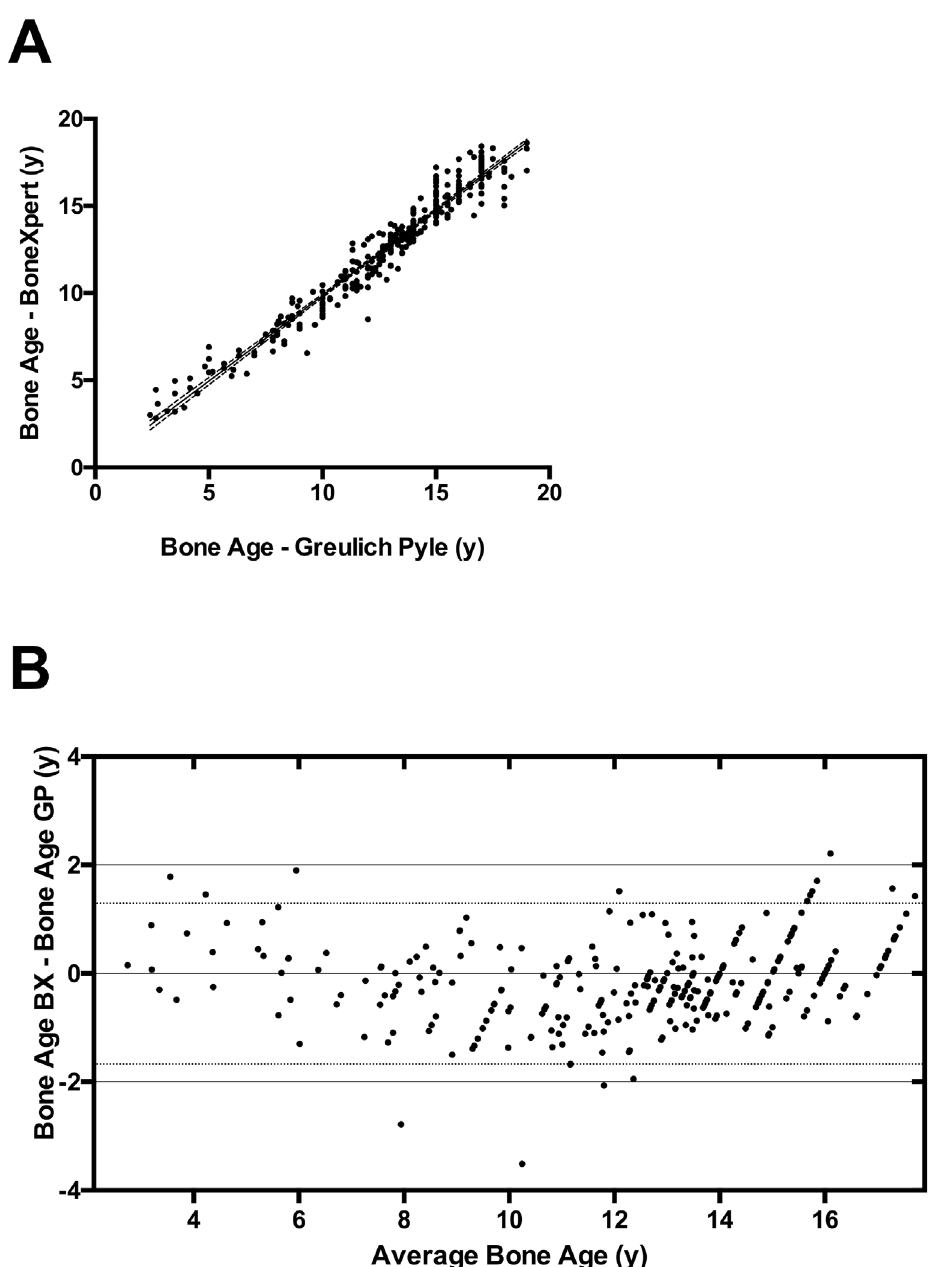
Fig 3. Comparison of manual and automated measurement of bone age. A) Bone age determined using BoneXpert as a function of manually measured bone age (Greulich and Pyle method). The predicted values, based on bivariate regression is indicated by the continuous line, the dashed lines represent the 95% confidence interval; r = 0.97; P < 0.0001). B) Bland Altman plot indicating the difference between automatic and manual rating for the licensed range of application of the BoneXpert software. The average of the two rating methods is shown along the horizontal axis, the difference is indicated along the vertical axis. The dotted lines represent the 95% limits of agreement (bias = -0.188; SD of Bias